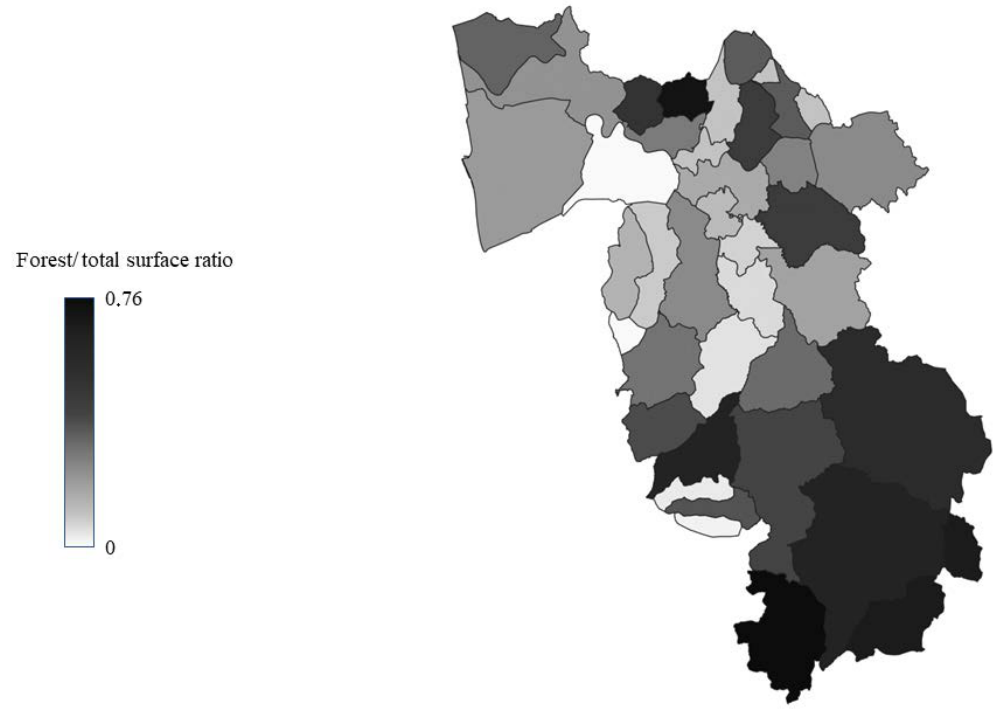
Figure 4. Municipalities in the province of Pisa classified according to the forest/total surface ratio.